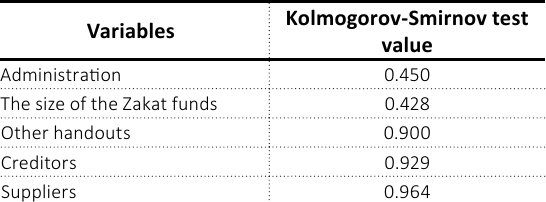
Table 1. One-Sample Kolmogorov-Smirnov test